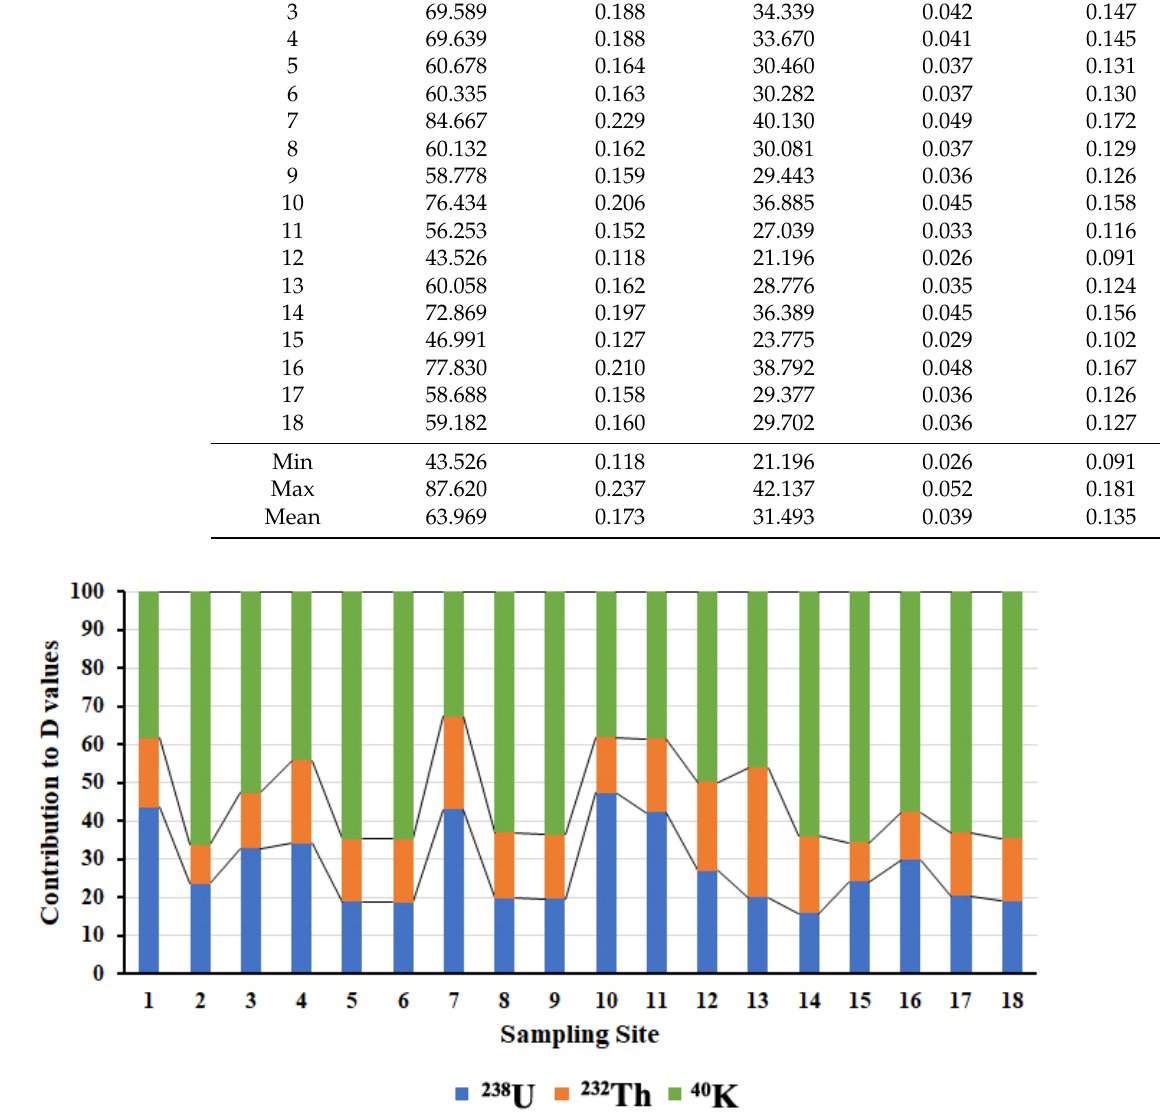
Table 4. Calculated radiological parameters in Jeddah Coast sediment.